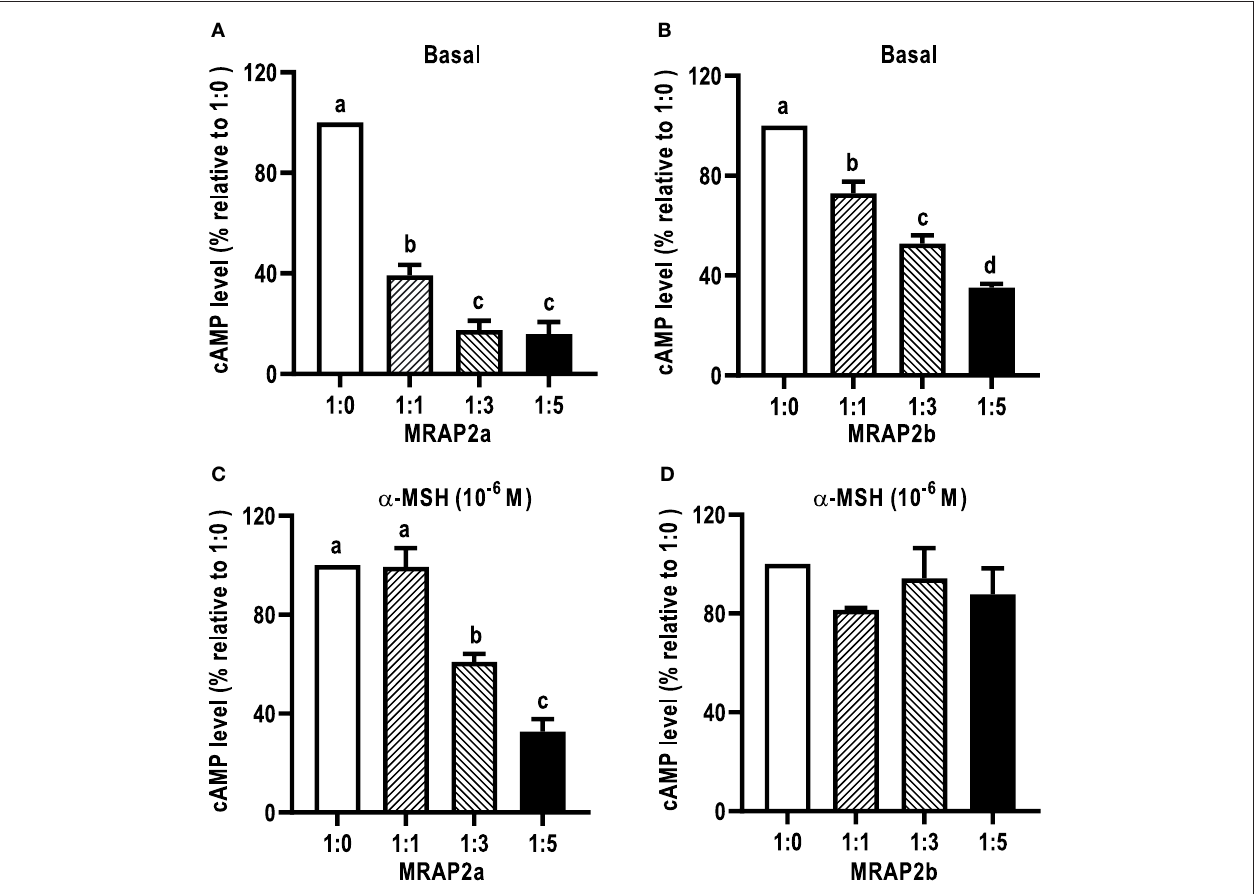
FIGURE 9 | The effects of caMRAP2a or caMRAP2b on caMC4R signaling. HEK293T cells were co-transfected with different ratios of caMC4R/caMRAP2a or caMC4R/caMRAP2b (1:0, 1:1, 1:3, and 1:5) and cAMP levels under basal (A,B) or stimulated [with 10 − 6 M α -MSH, (C,D) ] conditions were measured. Data are expressed as % of 1:0 group. Values are expressed as mean ± SEM ( n = 3). Different letters indicate significant difference (one-way ANOVA followed by